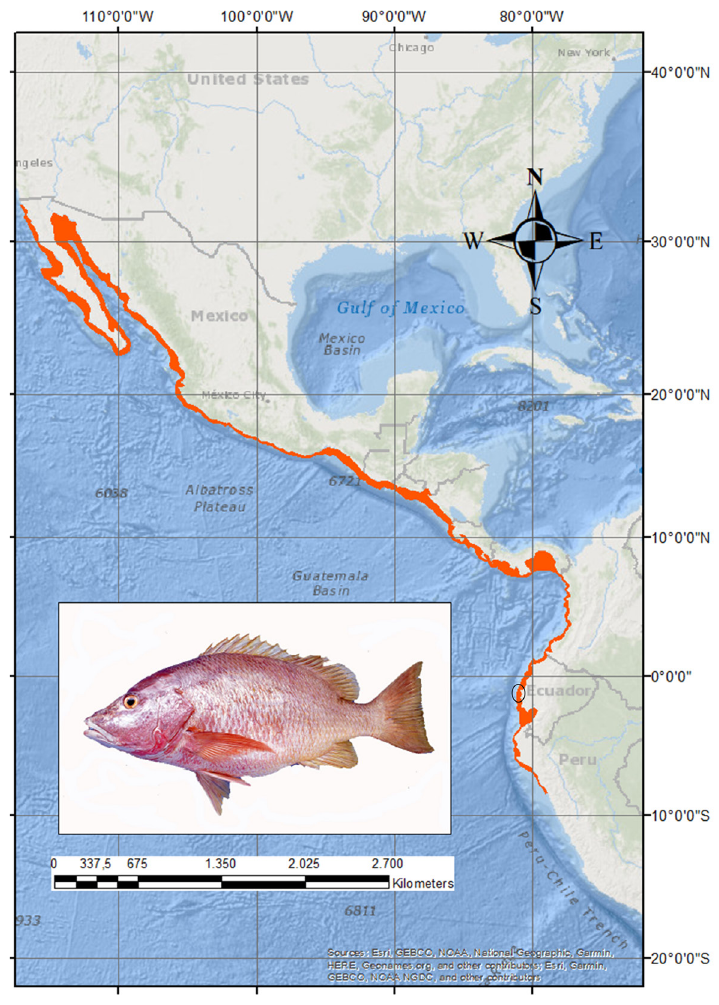
FIGURE 1 | Lutjanus argentiventris geographical distribution (Map adapted from Robertson, Allen, 2015; Image represents a 645 mm TL